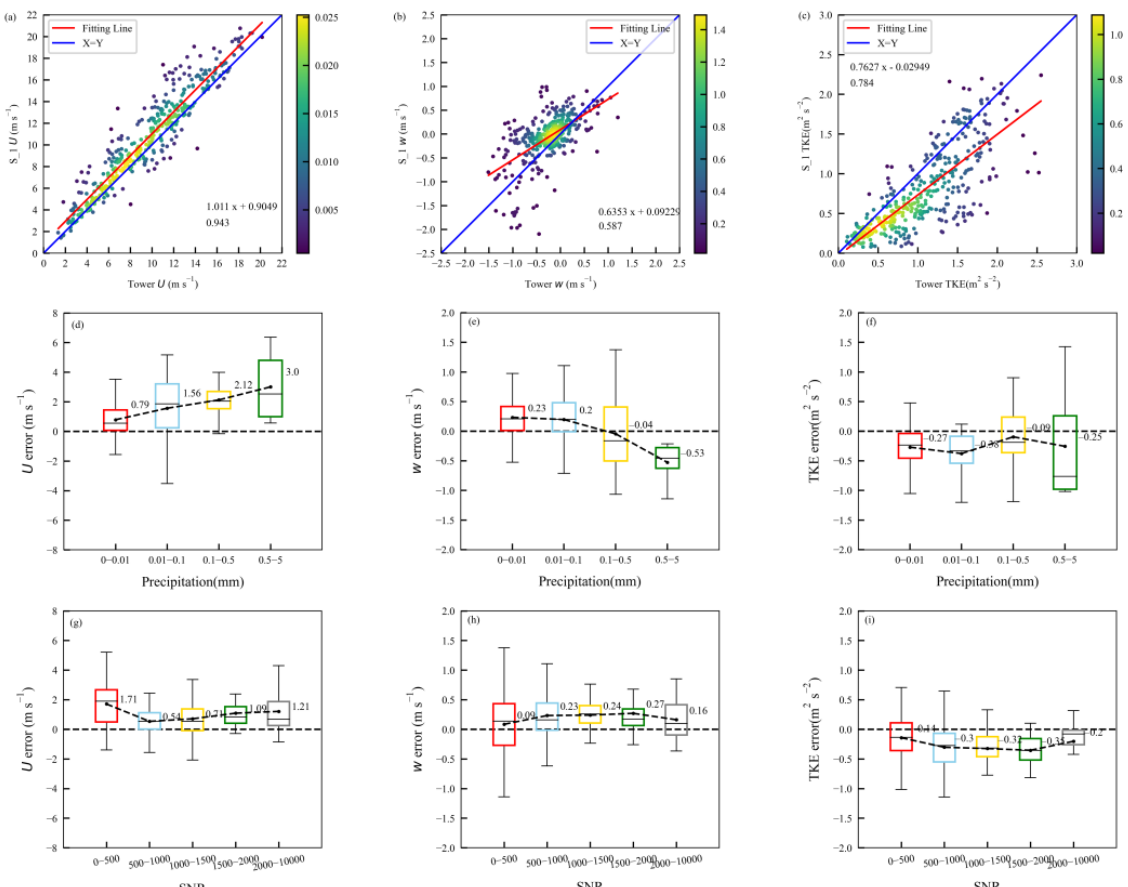
Figure 4. ( a – c ) Comparison of collocated S_1 and tower U , w , and TKE. Also shown are the line of best fit (red) and the line of perfect correlation (blue); ( d – f ) error in U , w , and TKE as a function of precipitation for S_1; ( g – i ) error in U , w , and TKE as a function of SNR for S_1.